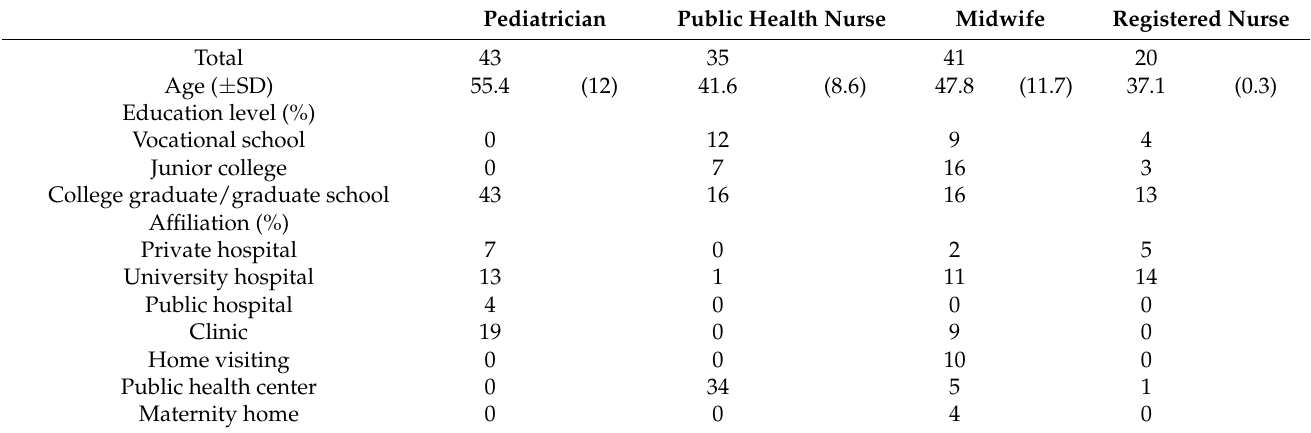
Table 1. Characteristics of study participants.